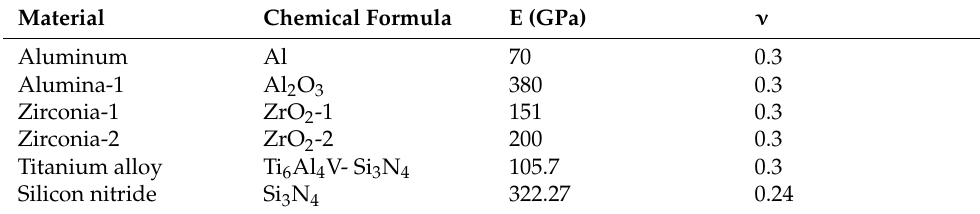
Table 1. Mechanical properties of the material used in functionally graded material.